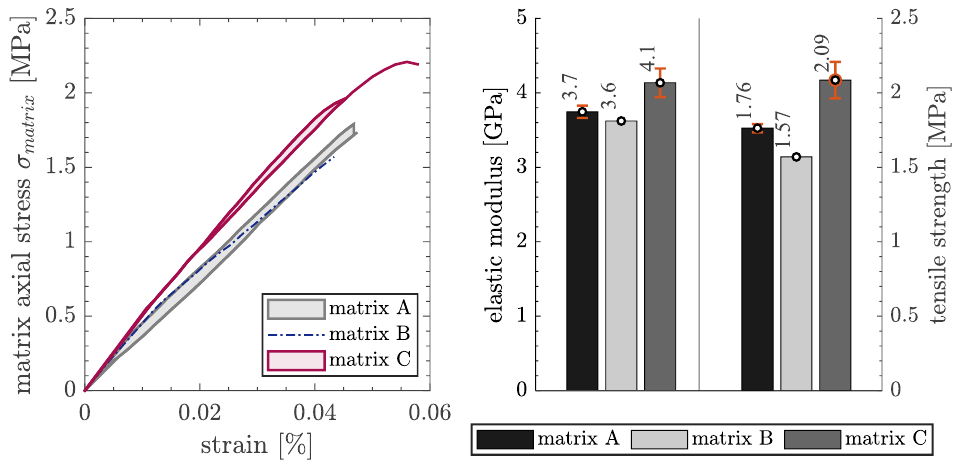
Figure 8. Stress – strain curves ( left ) and elastic modulus and tensile strength ( right ) of prismatic specimens realized with three different cement-based matrices without fabrics (plain matrix).